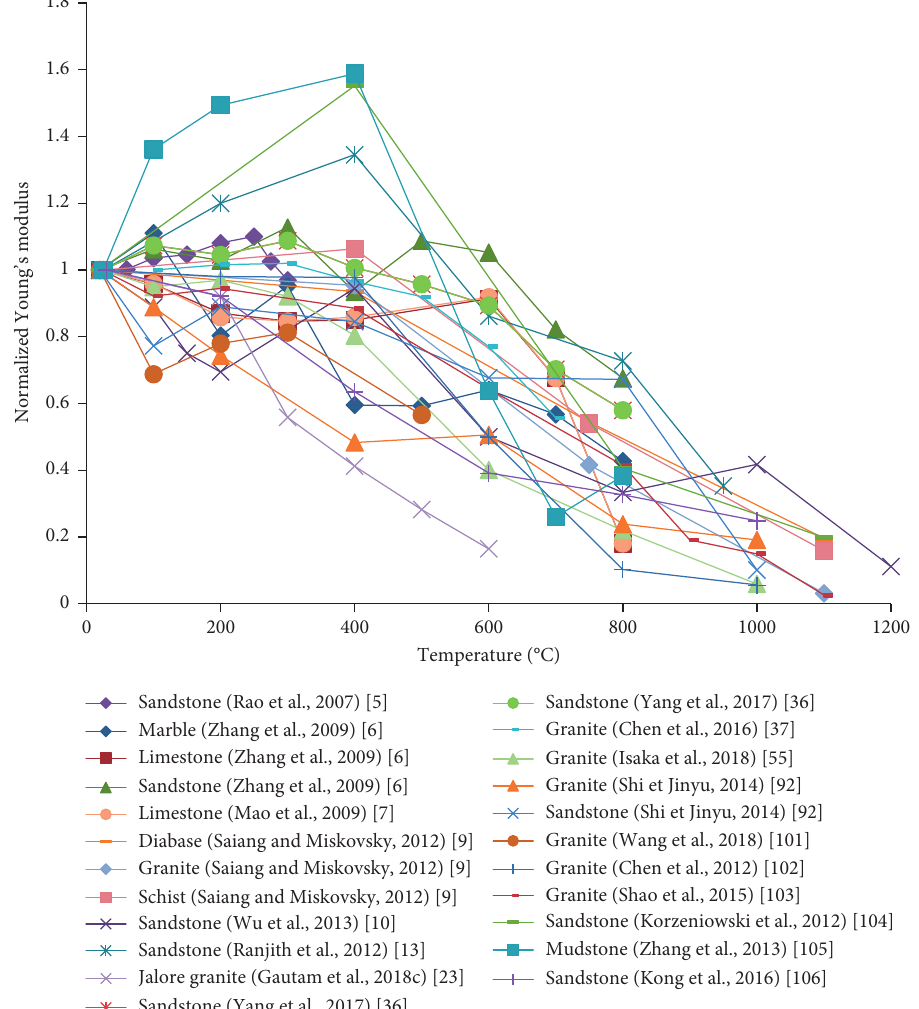
Figure 6: Normalized Young’s modulus of certain rocks as function of temperature.